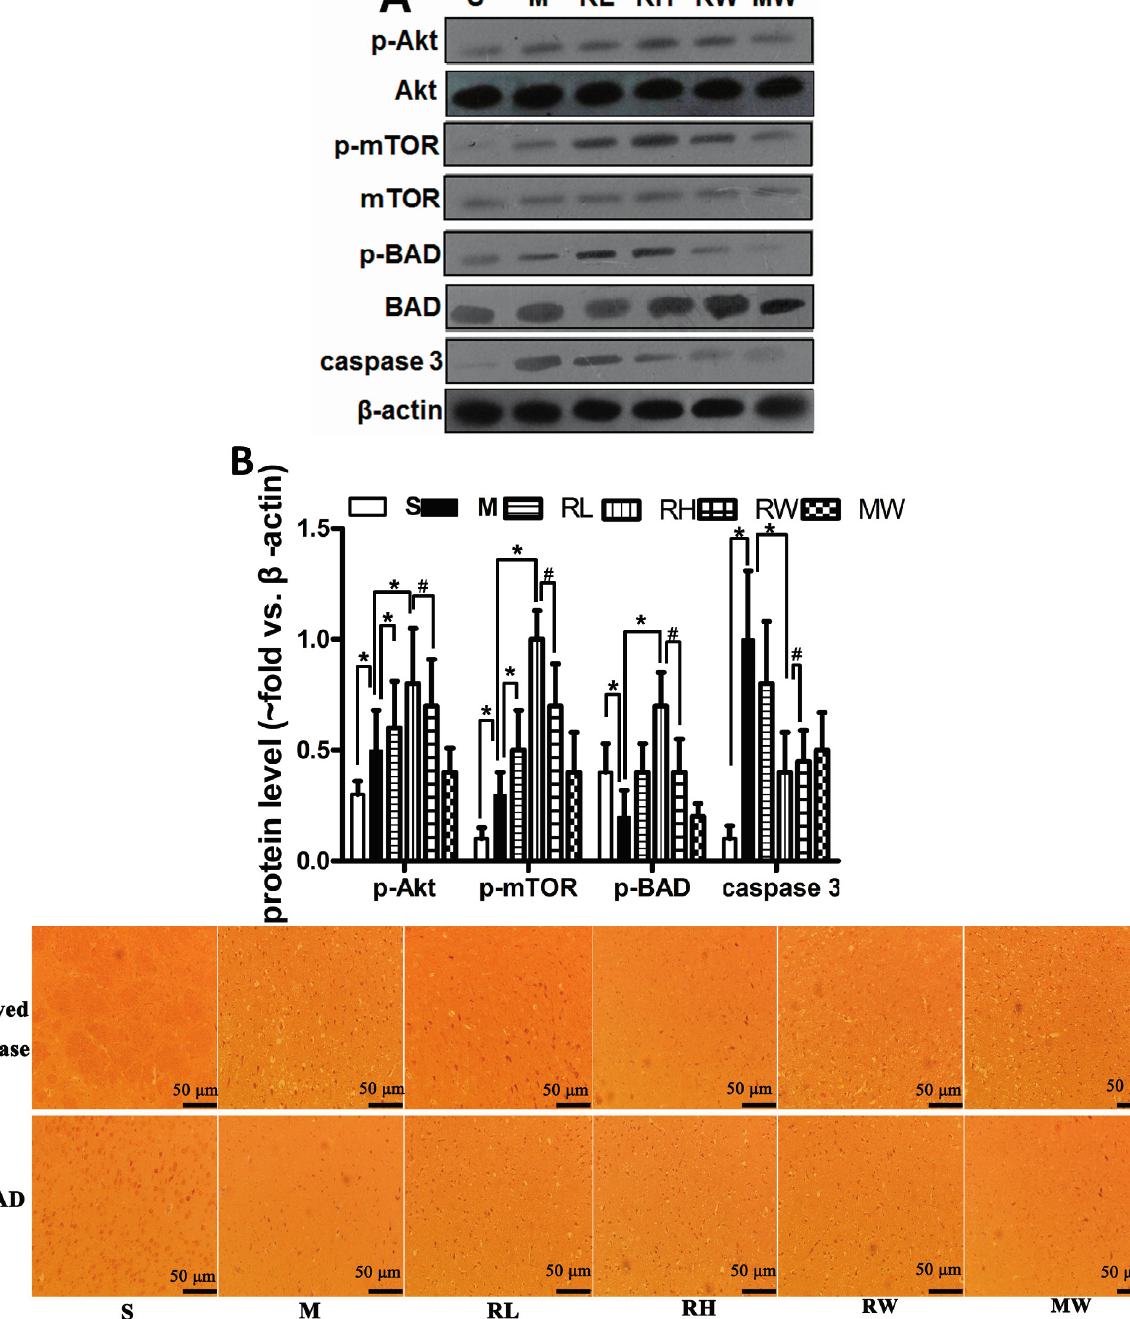
Figure 2. Effect of Rhy on the PI3K/Akt signaling and the downstream apoptosis-related proteins. ( A ) The expression of p-Akt, Akt, mTOR, p-mTOR, p-BAD, BAD, and cleaved caspase 3 in Sham (S), pMCAO (M), Rhy-L (RL), Rhy-H (RH), Rhy-H + wortmannin (RW) and pMCAO + wortmannin (MW) groups; ( B ) Densitometry analysis; ( C ) Immunohistochemical staining of p-BAD and cleaved caspase 3 at 24 h after pMCAO; ( D ) Bar graph shows quantitative data from each group ( * p < 0.05 Rhy and Sham vs. pMCAO, # p < 0.05 RW vs.